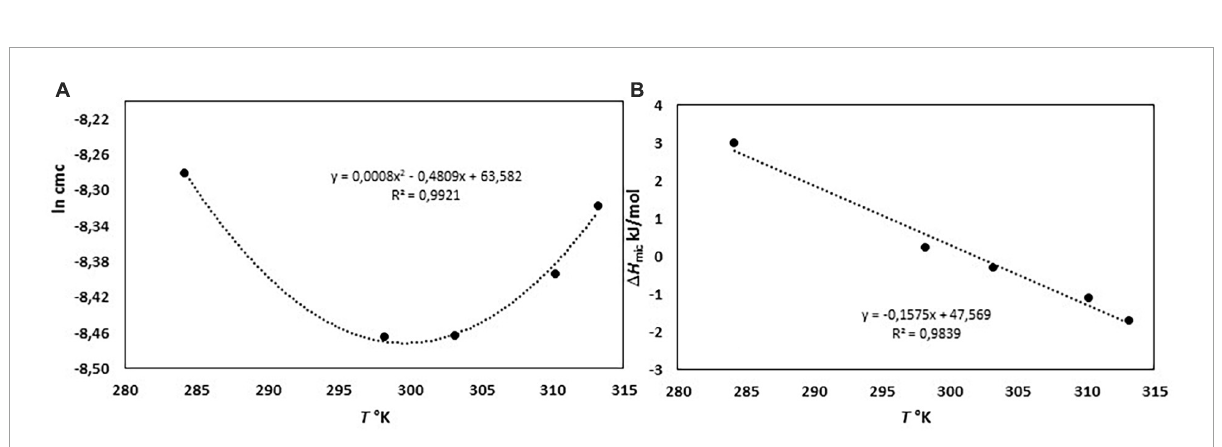
FIGURE2 (A) ln cmc (expressed as mole fraction) as a function of 1/T and (B) the micellization enthalpies as a function of T.